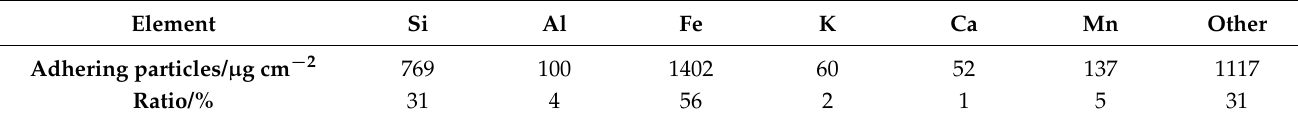
Table 3. EDX analysis of adhering particles for the used filter cloth based on